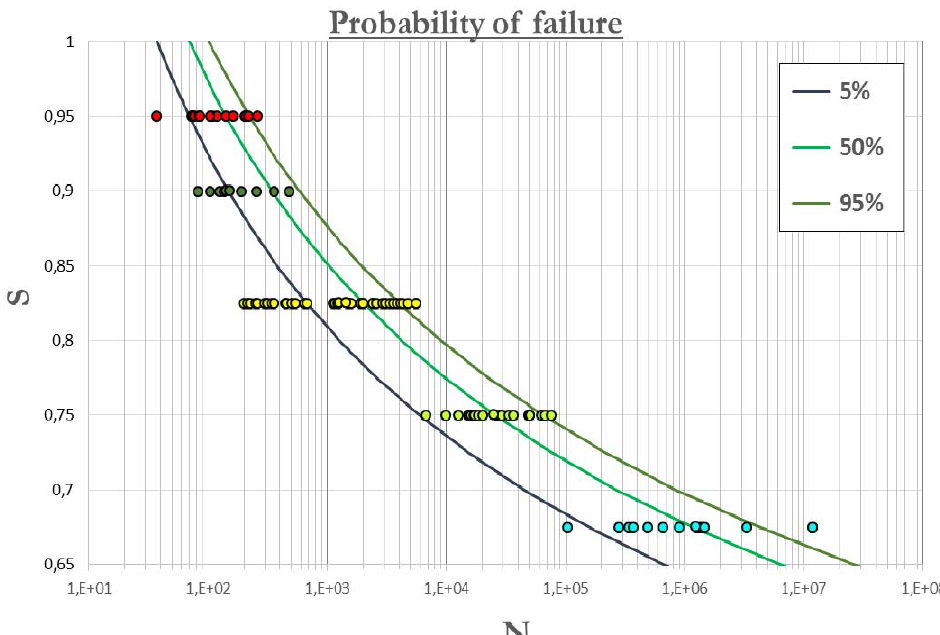
Figure 1: S-N field fitted with the Mc Call model [7] for the normalized fatigue results for concrete under compression from Holmen